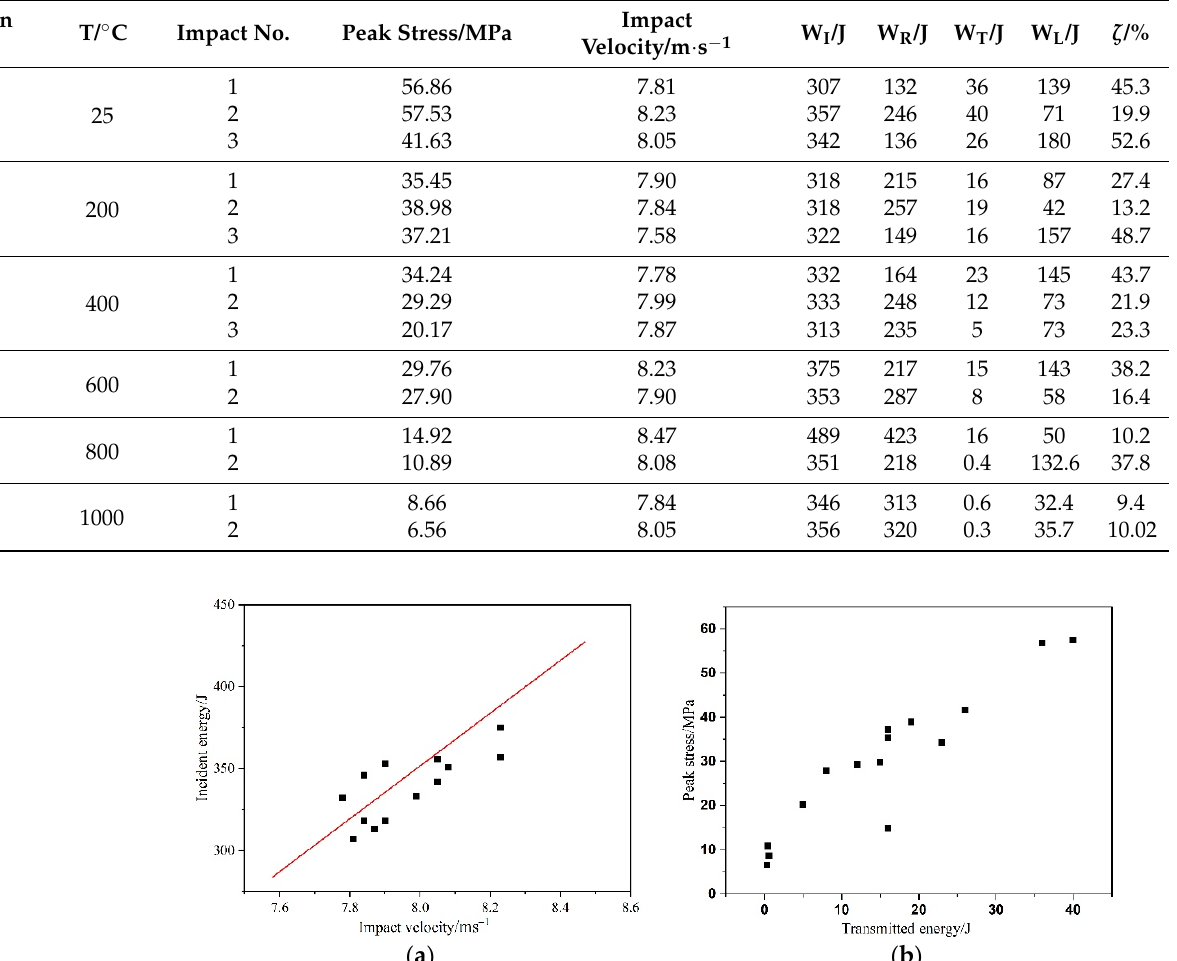
Figure 12. Analysis of cyclic impact energy of sandstone. ( a ) Relationship between impact velocity and incident energy. ( b ) Relationship between peak stress and transmitted energy. and incident energy. ( b ) Relationship between peak stress and transmitted